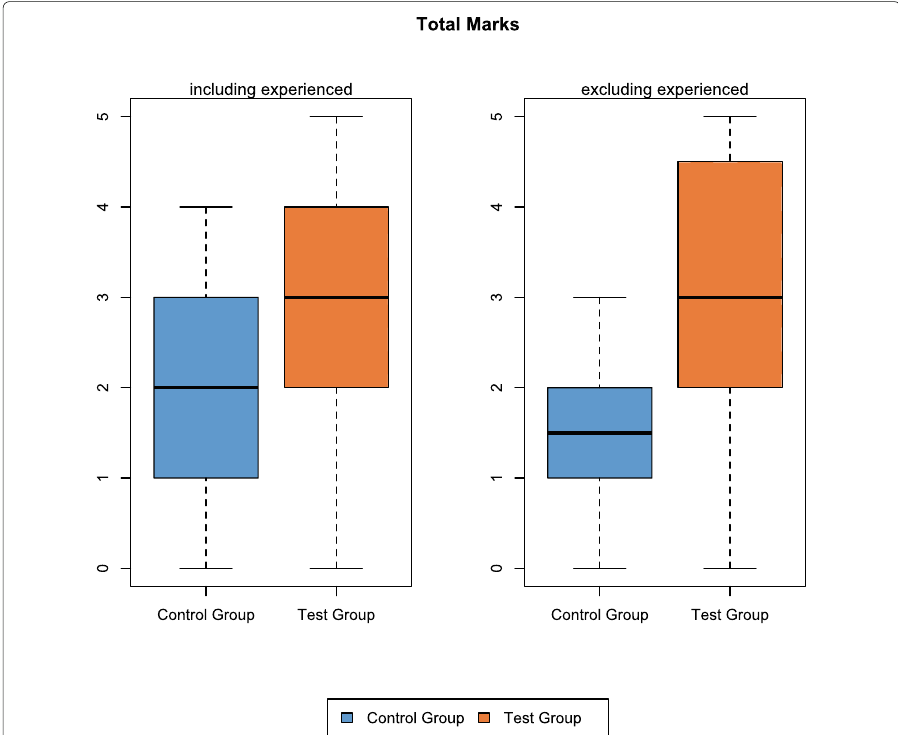
Fig. 13 Total marks for test and control group. By excluding individuals with previous experience, the outperformance of the test group becomes even more